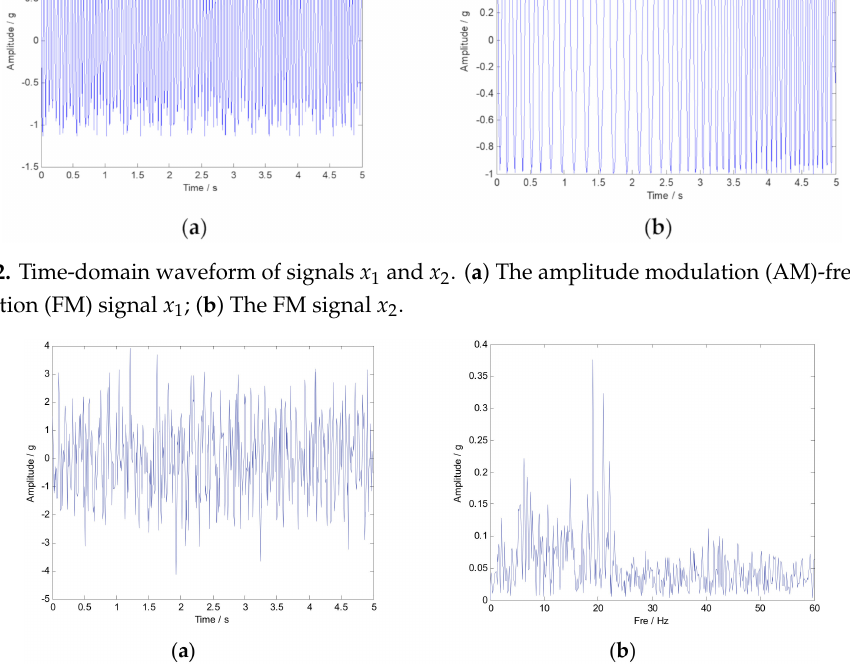
Figure 3. The multi-component signal shown in time and frequency domains. ( a ) Simulated signal shown in time-domain; ( b ) Simulated signal shown in frequency-domain.